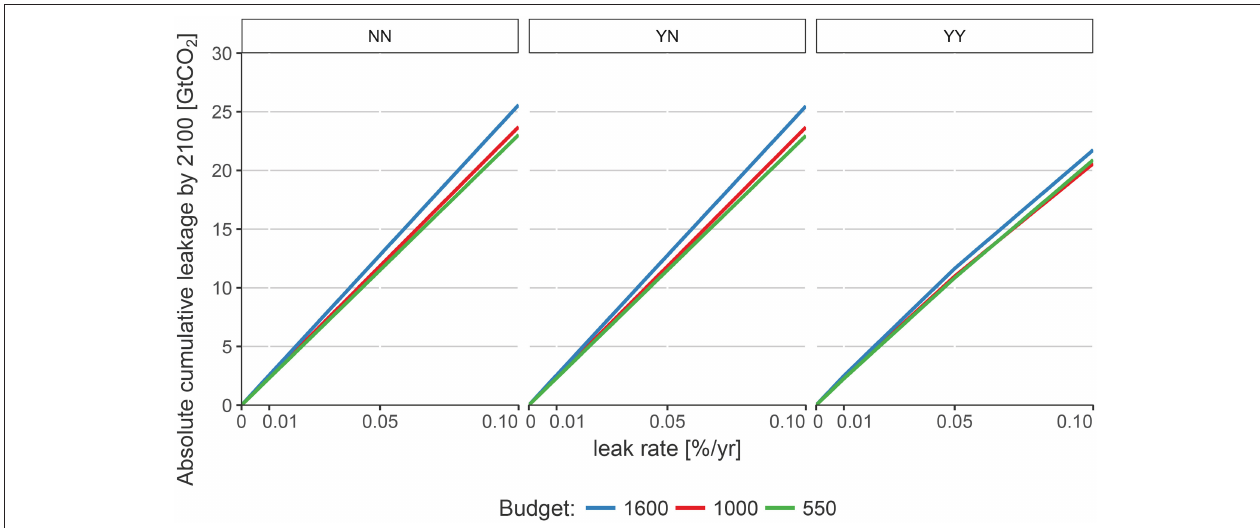
FIGURE 2 | Cumulative leaked emissions in the different scenarios [ GtCO 2 ]. Captured emissions are around 700–750 GtCO 2 for NN and YN scenarios and 650–700 GtCO 2 for the YY